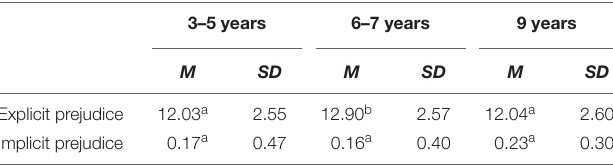
TABLE 2 | Means and standard deviations in children explicit and implicit ethnic prejudice across age